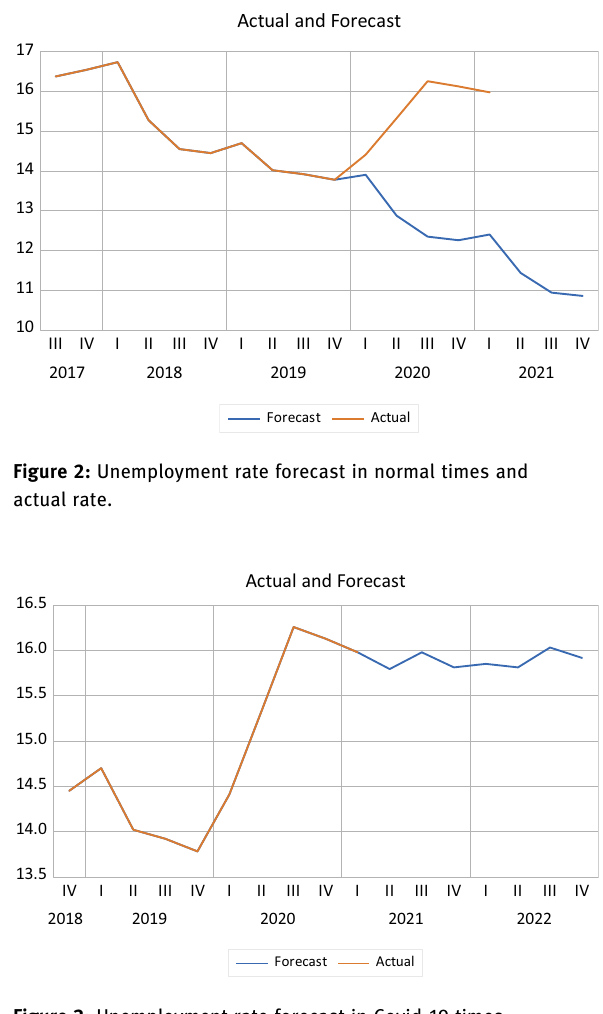
Figure 3: Unemployment rate forecast in Covid - 19